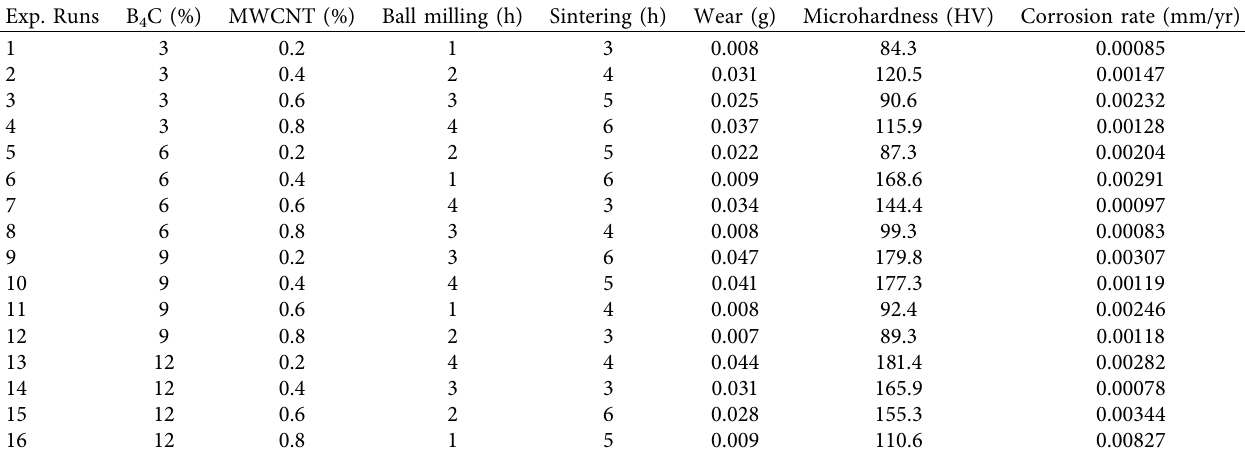
Table 3: Experimental summary of the P/M process parameters and the